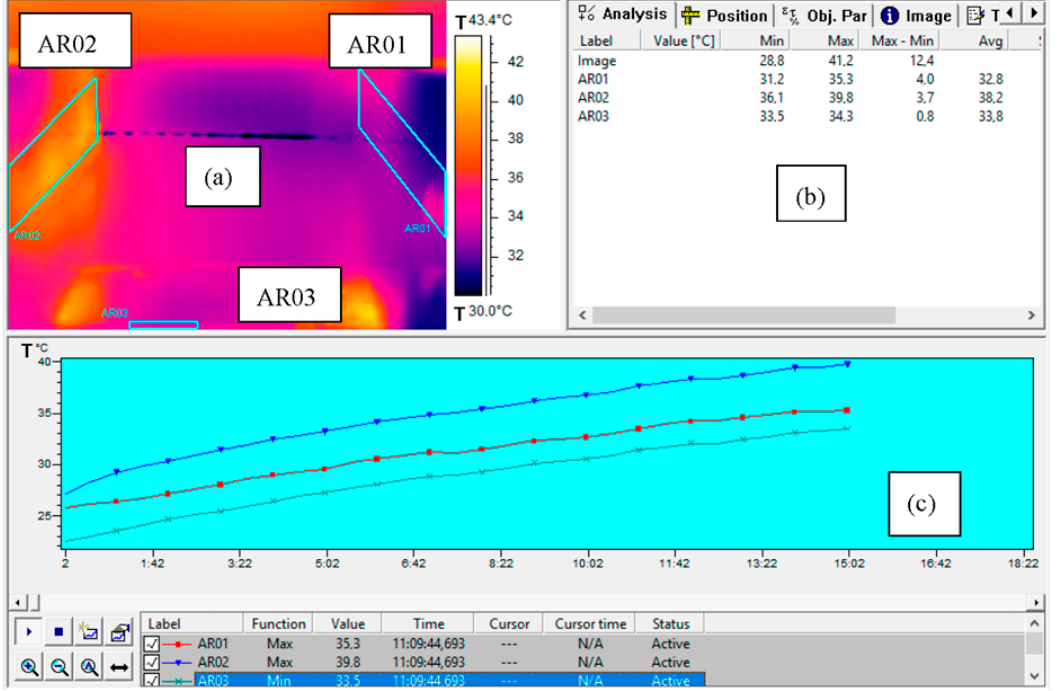
Figure 18. Temperature Measurement (20 kW) of each leg using MOSFETs CAS300M12BM2. ( a ) Infrared image of power stage; ( b ) Maximum, minimum and difference values measured in each AR0x zone; ( c ) Temperature evolution in each leg and heatsink; blue: AR02 (Q 1 –Q 2 ); red: AR01 (Q 3 –Q 4 ); green: AR03